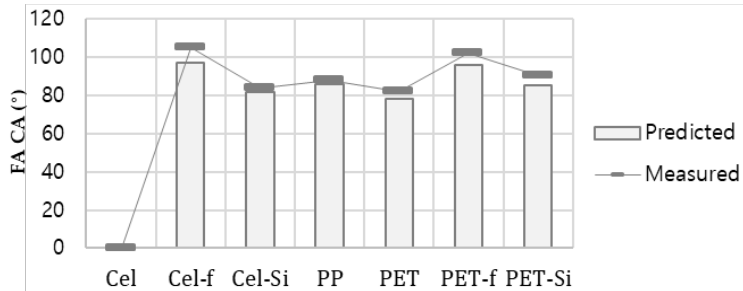
Figure 4. Contact angle of formamide (FA), actual measurement and estimation from Equation (10).